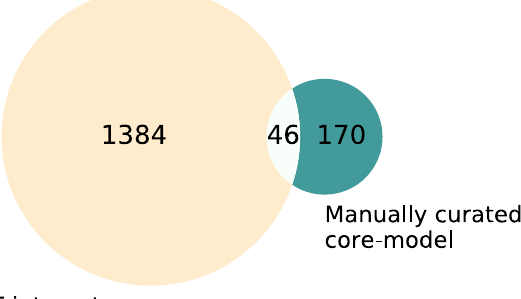
Figure 1. Venn diagram of the interactors in the manually curated core map vs. coarse map. The manually curated list of interactors within the core map comprises 170 interactors, the coarse map derived from high-throughput data contains 1384 interactors, and 46 interactors occur in both lists. The overlap was subtracted from the high-throughput interactome for the visualization to avoid redundancies, resulting in 1338 interactors in the coarse map.